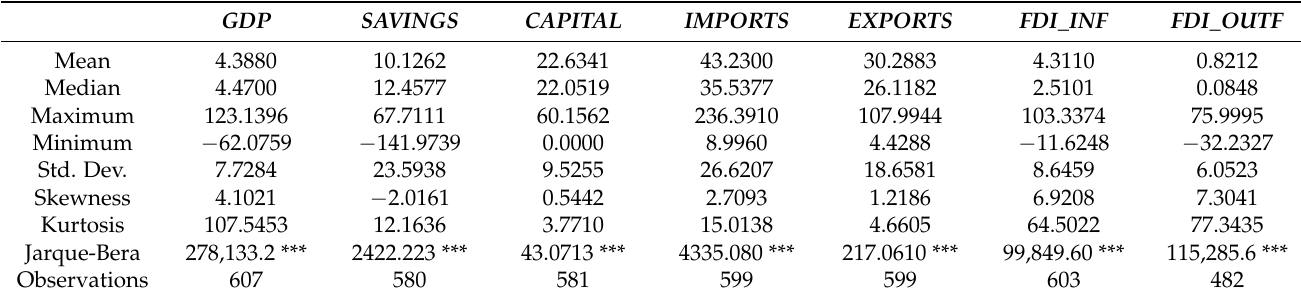
Table 1. Descriptive statistics.